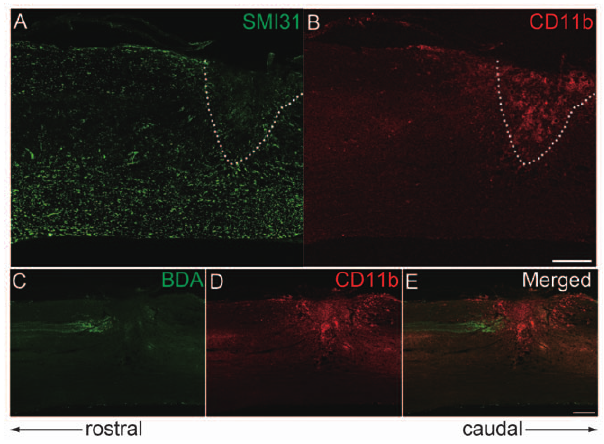
Figure 1. Transected axons do not regrow into the lesion of SCI where microglia/macrophages accumulate. A , B , Immunostaining of phospho-neurofilament (SMI31; A ; axon, green) and CD11b ( B ; microglia/macrophage, red) at day 7 after SCI. Scale bar: 500 m m. C – E , BDA-labeled CST fibers ( C , green) and CD11b ( D ; microglia/macrophage, red) at day 7 after SCI. Scale bar: 500 m m.